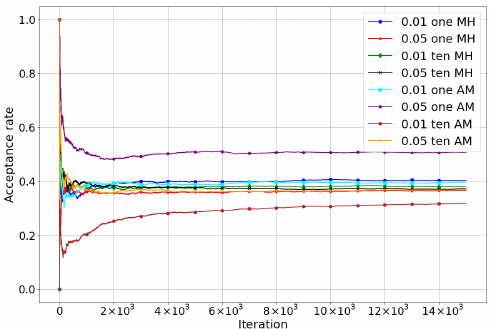
Figure 6. Acceptance rate over iteration for all